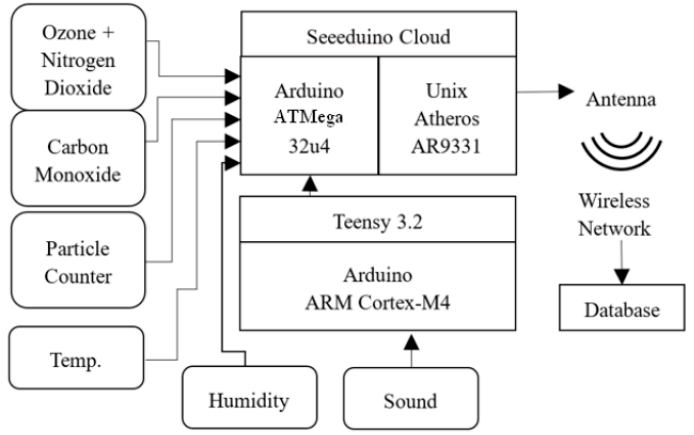
Figure 1. A block diagram of the sensor and microprocessor architecture.